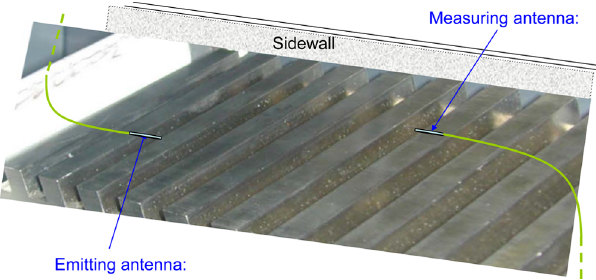
FIG. 4. Transverse profiles of the four lowest symmetric modes for the grating with sidewalls (a), and the three lowest antisymmetric modes (b). The nodes and loops are